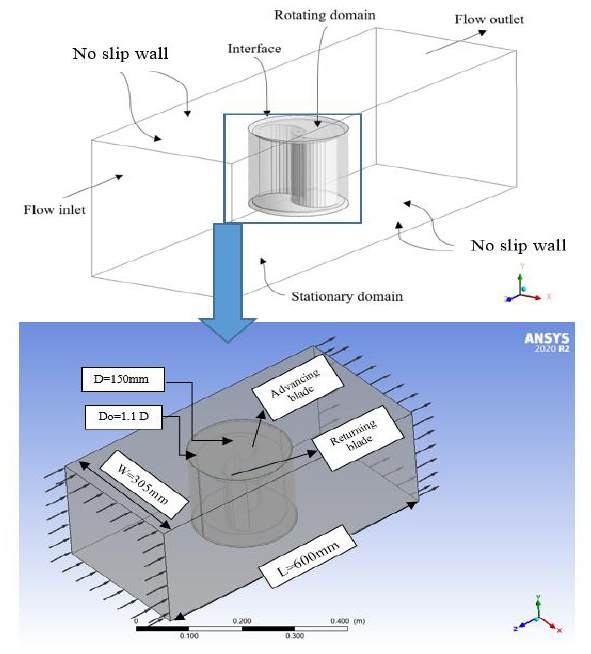
Figure 5. 3D computational domain with boundary conditions.